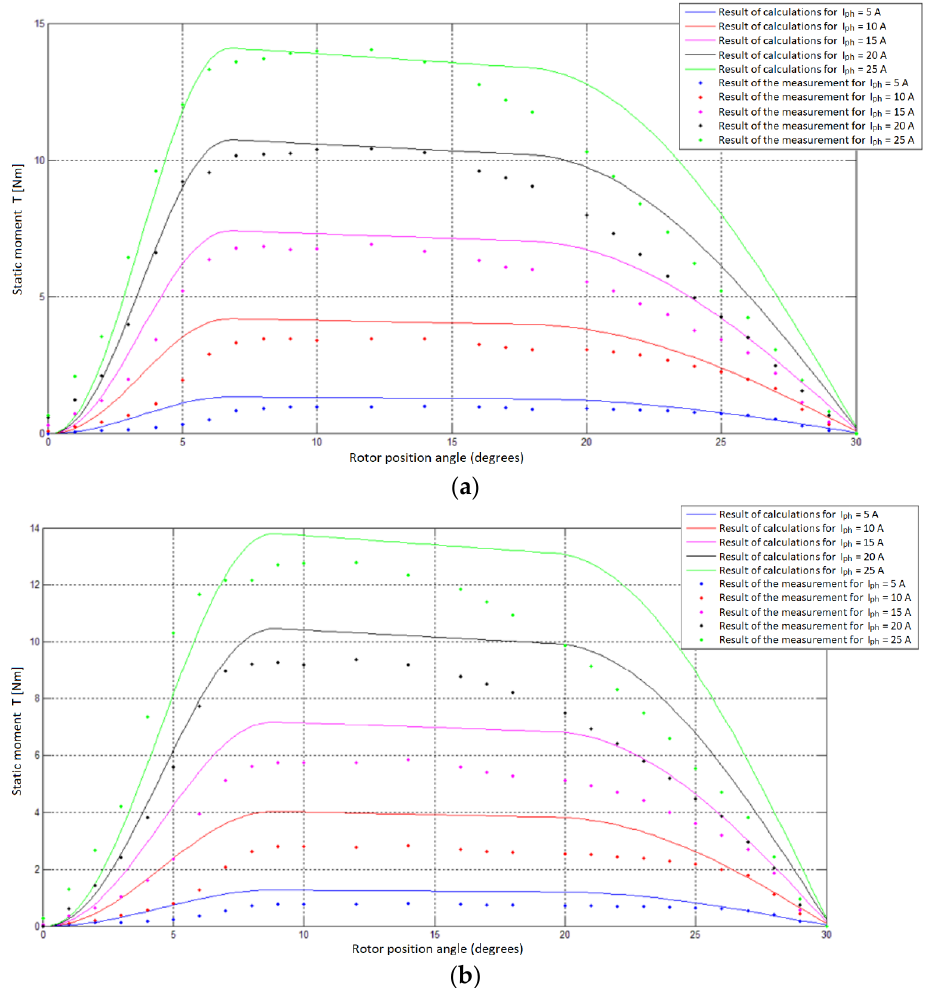
Figure 12. Summary of calculation results (solid lines) with measurement results (dotted lines) for the symmetrical SRM 8/6 with: ( a ) straight poles; ( b ) oblique poles.